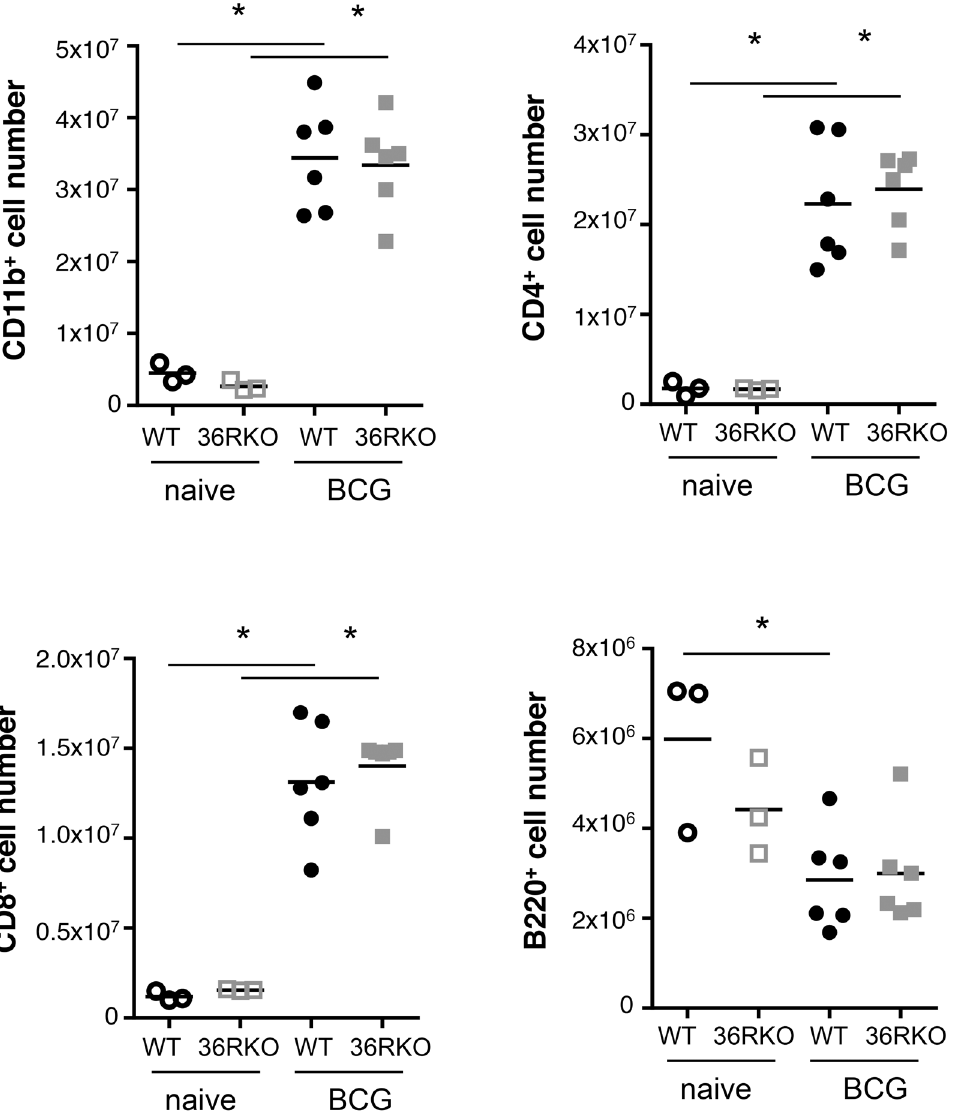
Fig 4. Changes in lung cell populations following M . bovis BCG inoculation. Lung cells were isolated from 3 naive WT and IL-36R deficient mice, and from 6 WT and 6 IL-36R deficient mice 4 weeks after intravenous M . bovis BCG inoculation. The results represent CD11b + , CD4 + , CD8 + , and B220 + cell numbers as assessed by flow cytometric analysis. * P < 0.05, as assessed by Kruskal-Wallis, followed by Mann-Whitney